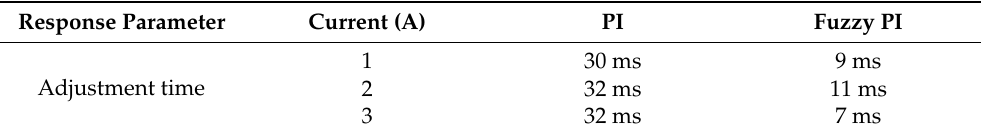
Table 6. Adjustment time of PI and fuzzy PI controllers at different step currents after parameter changes.